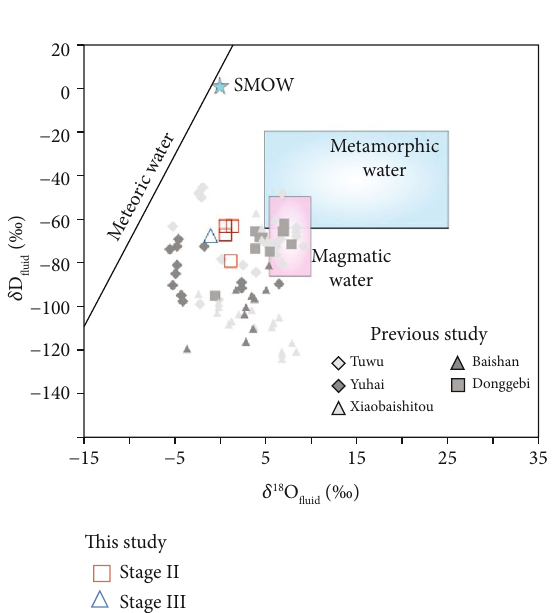
δ 18 O Figure 11: δ D fl uid vs. fl uid values from various stages in the Tieling Cu-Mo deposit. Fields for magmatic and metamorphic water are from Taylor [50] and Sheppard [51]. The data of previous studies were referenced from Zhang et al. [54], Zhang et al. [25], Liu et al. [55], Wang et al. [56], and Li et al.